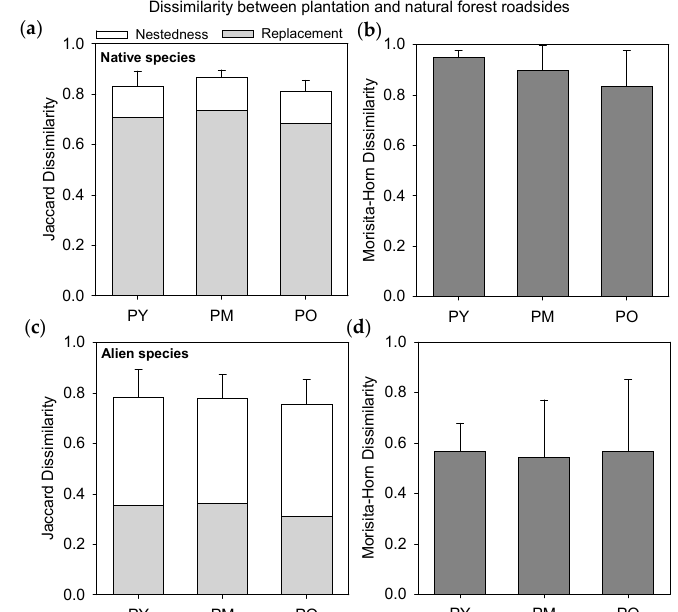
Figure A1. Mean pair-wise dissimilarity for native and alien species between transects of natural forest roadsides and roadside transects of young plantations (PY), medium-aged plantations (PM) and old to mature plantations (PO). ( a , c ): Presence/absence-based Jaccard dissimilarity partitioned into the replacement and nestedness component according to Baselga [50] for native ( a ) and alien ( c ) species; ( b , d ): The abundance-based Morisita–Horn Index for native ( b ) and alien ( d ) species. There were no significant differences among plantations age classes.